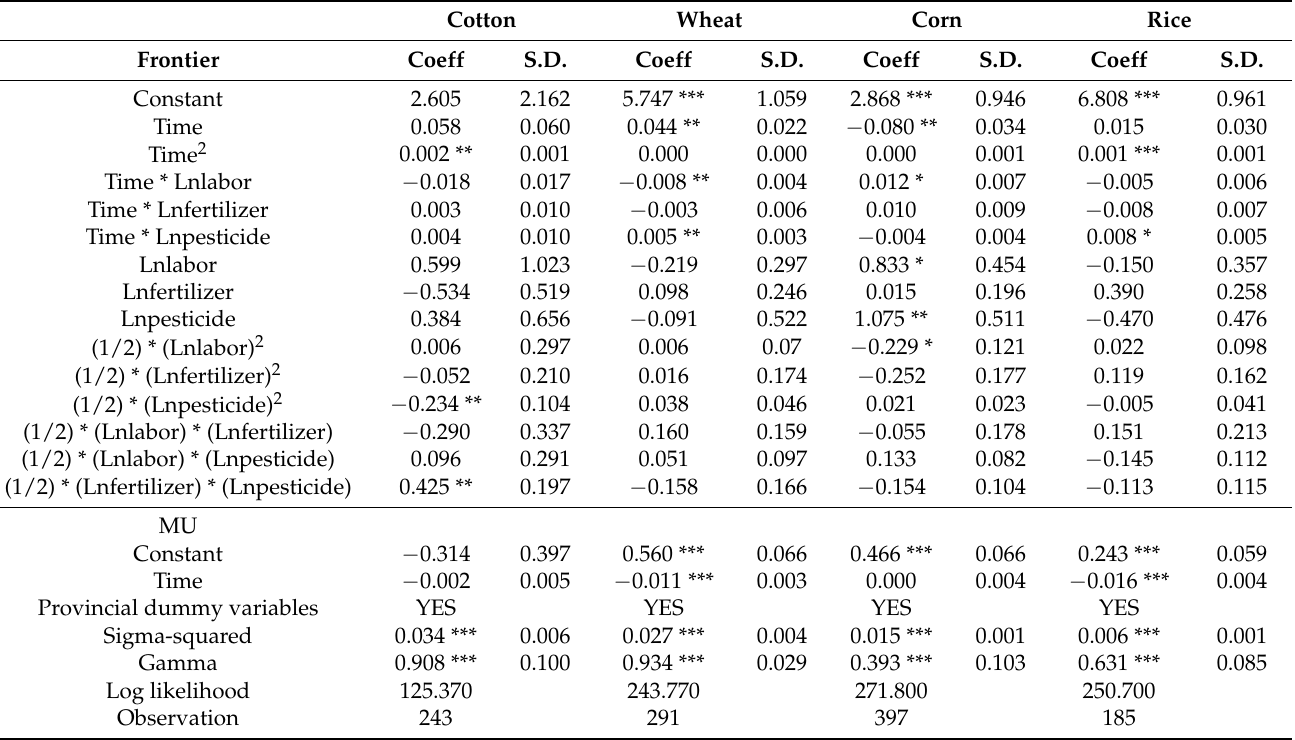
Table 1. Estimation results of Translog production function. Cotton Wheat